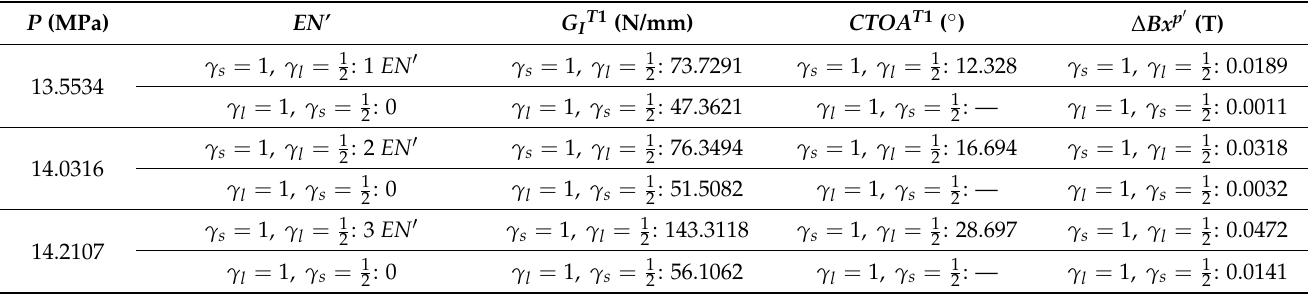
Table 9. Changes of the interference parameters γ l and γ s for the third set of the simulation examples.